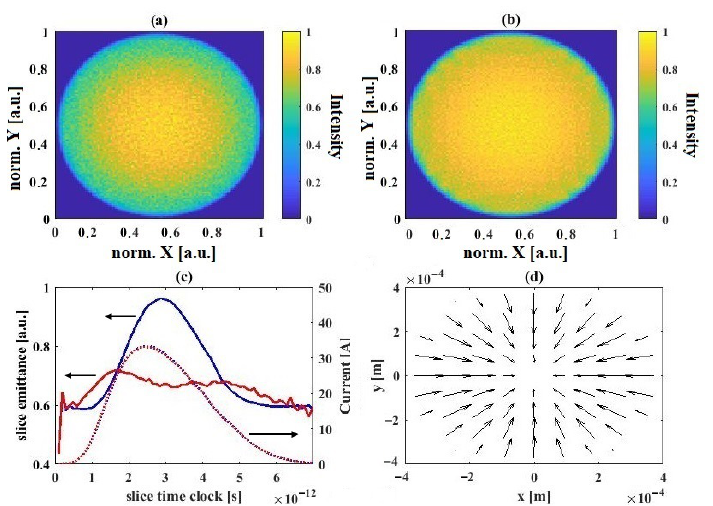
Figure 3. A transient view for the characteristics of near-cathode particle dynamics at the end of the photoemission process. ( a ) on-tracking transverse particle distribution for a truncated-Gaussian (TG) laser distribution with an optimal truncation ratio at the cathode; ( b ) on-tracking transverse particle distribution for a transverse uniform (RU) laser distribution at the cathode; ( c ) comparison of slice emittance along the bunches at the end of the photoemission between bunches ( a , b ); ( d ) vector plot of relative displacements on the transverse plane of the macro-particles in bunch ( a ) with respect to bunch ( b ). The arrows point from the macro-particles in ( b ) to those in ( a ), in which these macro- particles paired in the vectors are born at the same time clock at the cathode. The length of the arrows corresponds to the displacements in meter at this